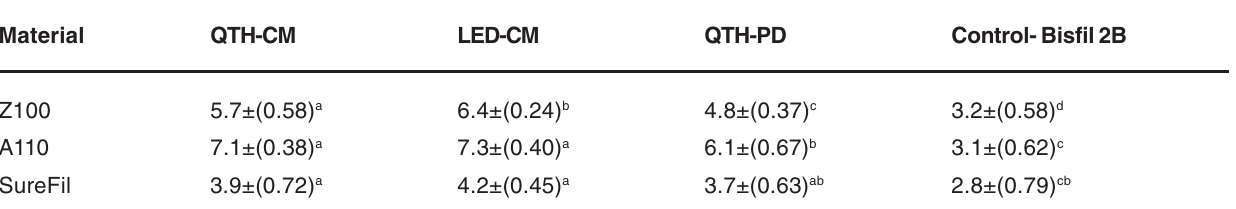
Same letters in horizontal line = no statistically significant difference ; p<0.05. TABLE 5- Experimental groups and mean of stress areas (mm 2 )